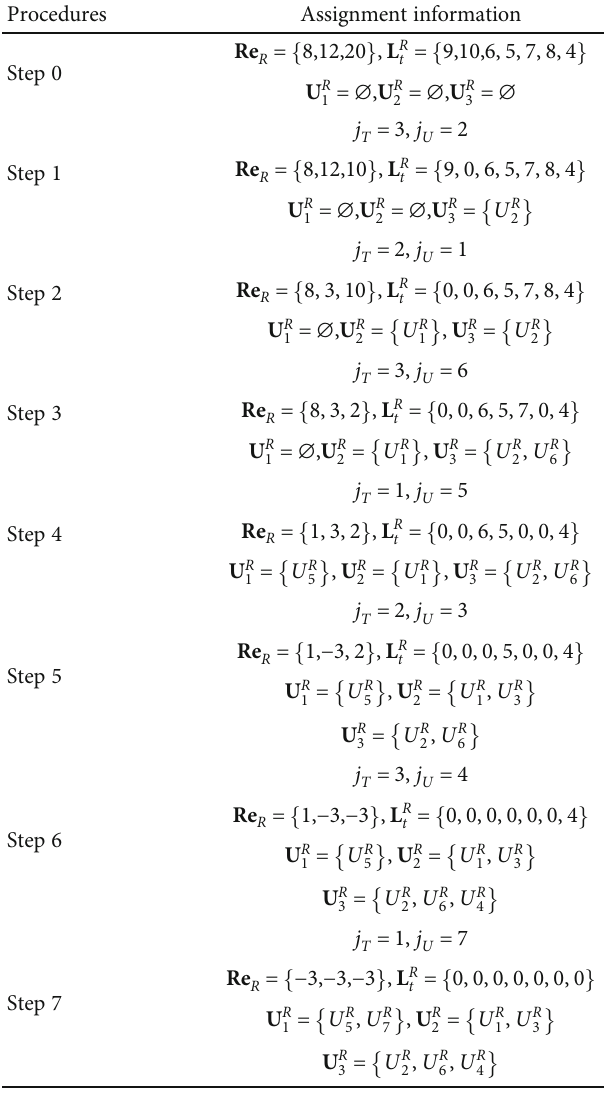
Algorithm 2: Negotiation-based assignment of R-UAVs. Table 1: Demonstration of R -UAV allocation based on negotiation